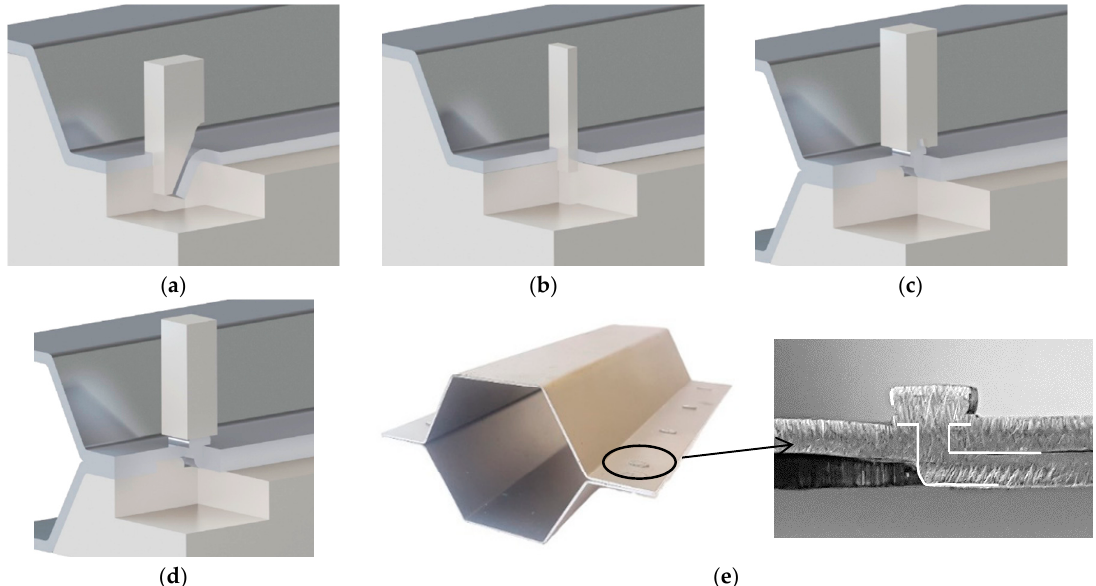
Figure 1. New fabrication process to assemble the individual formed panels of thin-walled crash boxes with double-hat shaped sections: ( a ) lancing (shearing and bending) of the tenon; ( b ) shearing of the mortise; ( c ) sheet-bulk compression of the tenon with a tapered punch; ( d ) mechanical locking by sheet-bulk compression of the tenon with a flat punch; ( e ) cross-section of a “mortise-and-tenon” joint. Note: the lancing in ( a ) is upside-down in order to replicate the press movement.